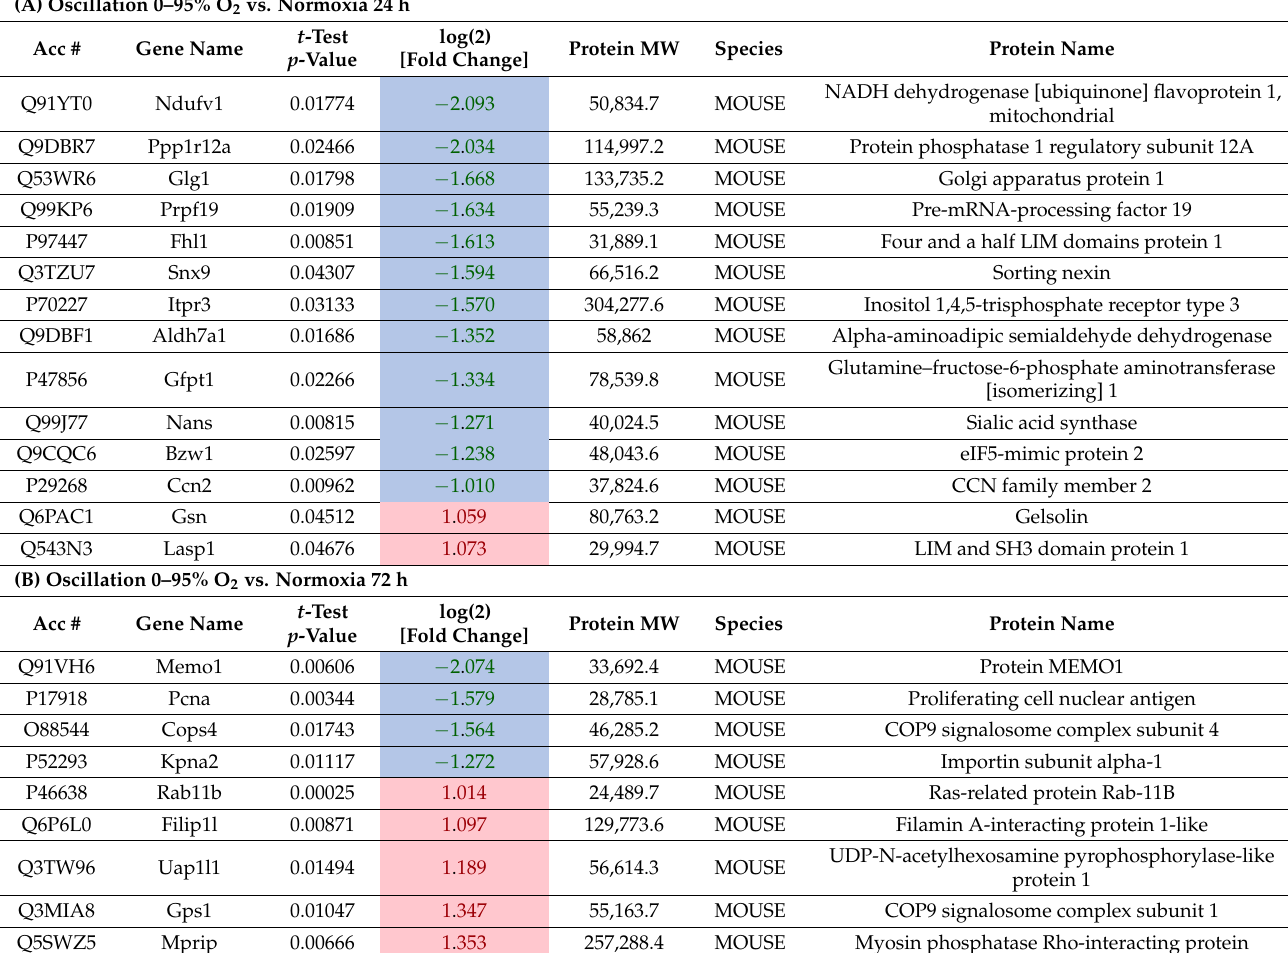
Table 2. Differentially expressed proteins (DEPs) after 24 h and 72 h exposure to hypoxic-hyperoxic oscillations. Murine lung endothelial cells were exposed for 24 h ( A ) and 72 h ( B ) to 0–95% O 2 oscillations. Semi-quantitative proteomic analysis revealed statistically significant changes in protein expression (blue: downregulated DEPs; red: upregulated DEPs). Results are log(2) fold changes compared to exposure under 21% O 2 for the same period of time. Statistical evaluation: two-sample t -test assuming unequal